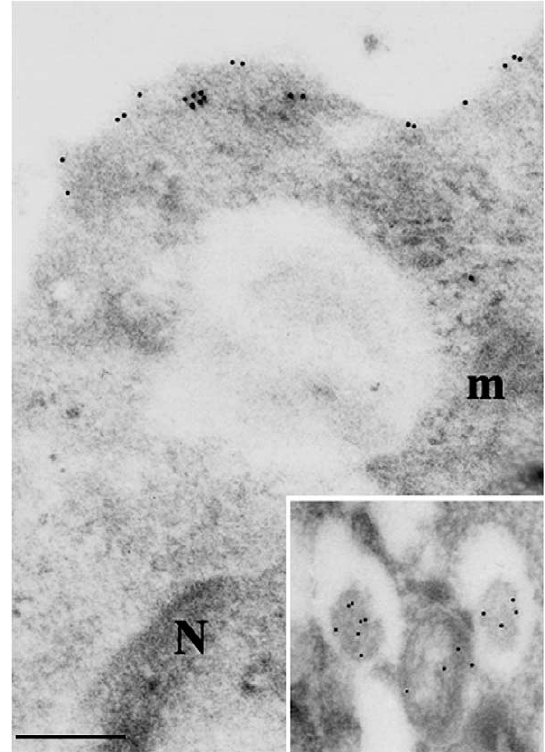
Fig. 4. Breast epithelial cells floating in Cancer NAF immunela- belled with anti-human Erythropoietin antibody. The labelling oc- curs on free ribosomes, dispersed in the cytosol and along the cell surface, whereas the cell nucleus (N) and the mitochondria (m) are devoid of gold grains. In the inset, the Epo labelling concentrated in vesicular structure containing homogeneous slightly electron-dense material is visible. Bar 0.5